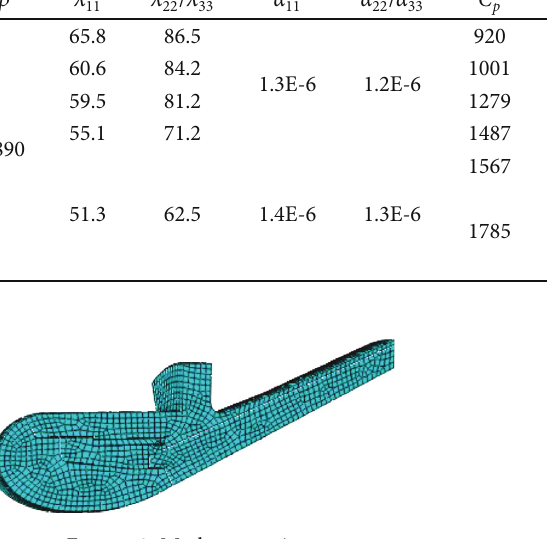
Figure 2: Mesh generation.